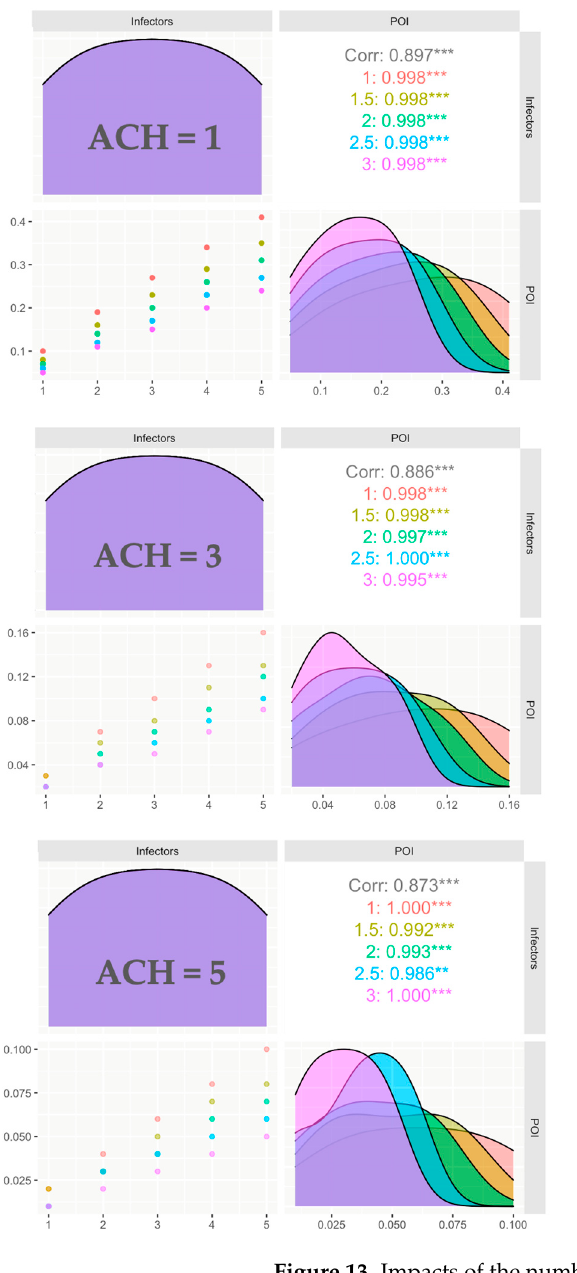
Figure 13. Impacts of the number of infectors, ventilation rate, and social distance on the probability of infection.